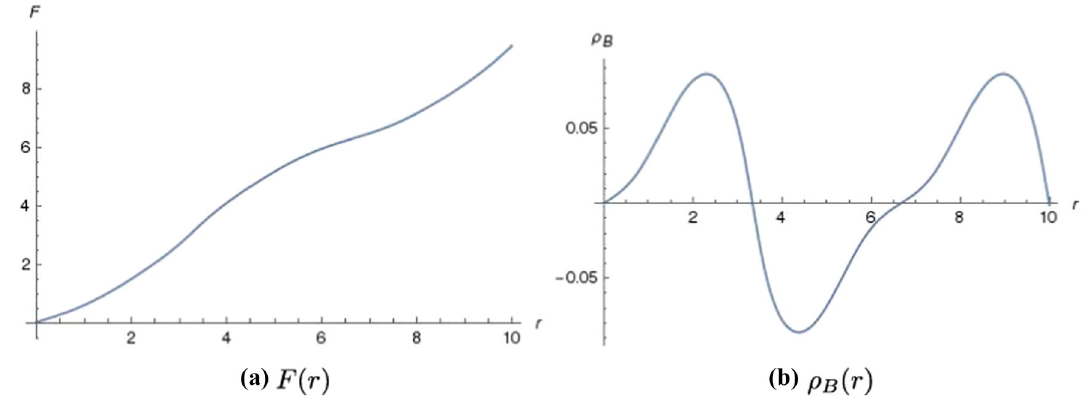
Fig. 3 Solution with n = 1